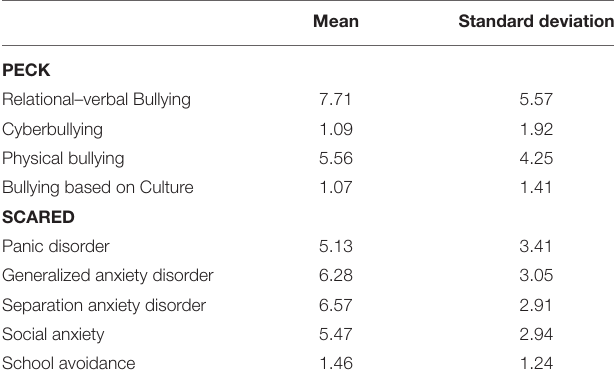
TABLE 3 | Mean and standard deviations of bullying victimization and anxiety ( N =